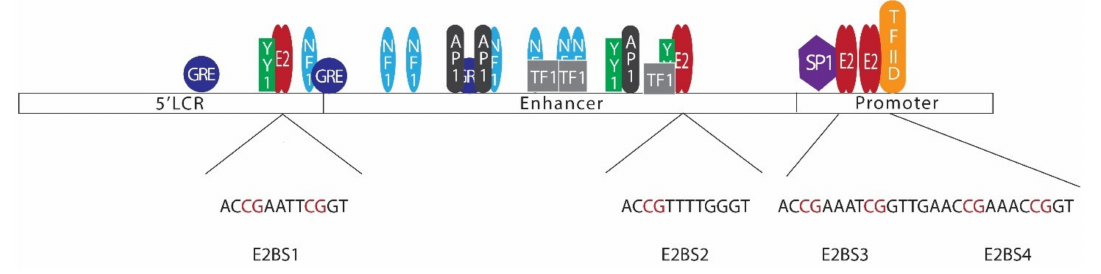
Figure 3. Arrangement of E2 binding sites in the HPV 16 long control region (LCR). The HPV 16 LCR can be subdivided into 3 sections, namely the 5’LCR, enhancer, and promoter regions. Binding of transcription factors such as YY1, NF1, GRE, AP1, SP1, TF1, and TFIID regulates viral early gene transcription. LCR consists of 4 E2 binding sites with a common palindromic sequence of ACCG(N) 4 CGGT (E2BS2 has a slight di ff erence in the sequence). Several CpG sites are located in LCR E2 binding sites